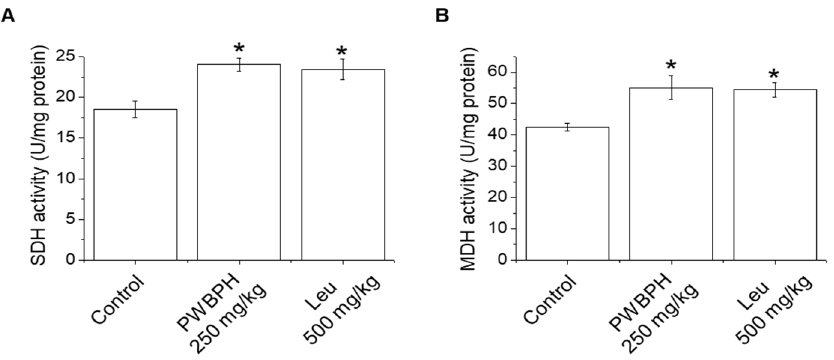
Figure 3. Effect of PWBPH on SDH and MDH activities. ( A ) SDH and ( B ) MDH activities in QF muscle of mice ( n = 6) measured using commercial kits. * p < 0.05 vs. control group. Abbreviations: SDH, succinate dehydrogenase; MDH, malate dehydrogenase).